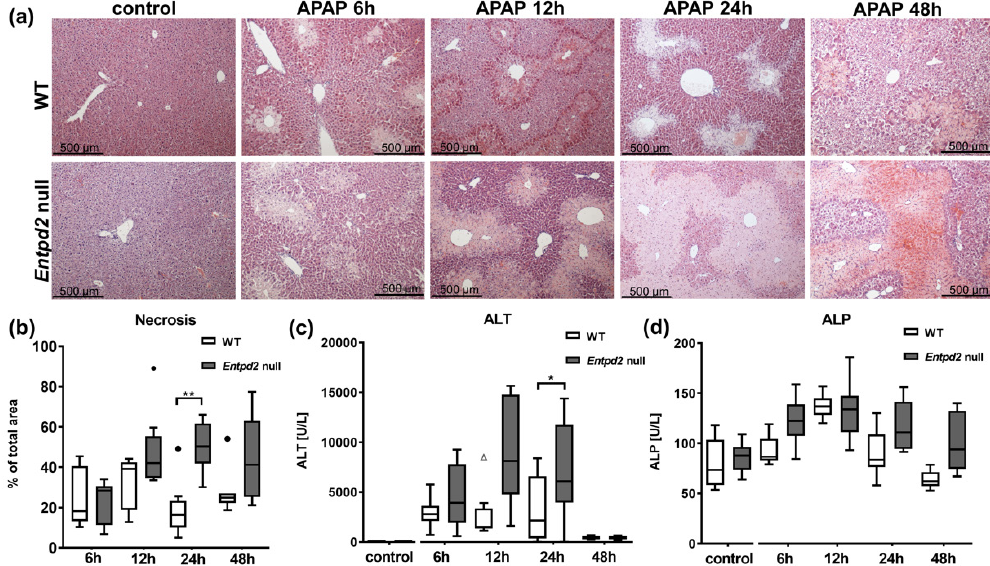
Figure 2. Liver injury after APAP intoxication in WT and Entpd2 null mice. ( a ) Representative histopathological images of liver histology for controls and after 12 and 24 h post APAP intoxication by hematoxylin and eosin (H&E) staining in WT vs. Entpd2 null livers (100 × ) ( b ). Percentage of necrotic areas per high-powered field (HPF), time course of ( c ) plasma ALT levels and ( d ) plasma ALP levels ( n = 6–8 per time point). * p < 0.05, ** p < 0.01.